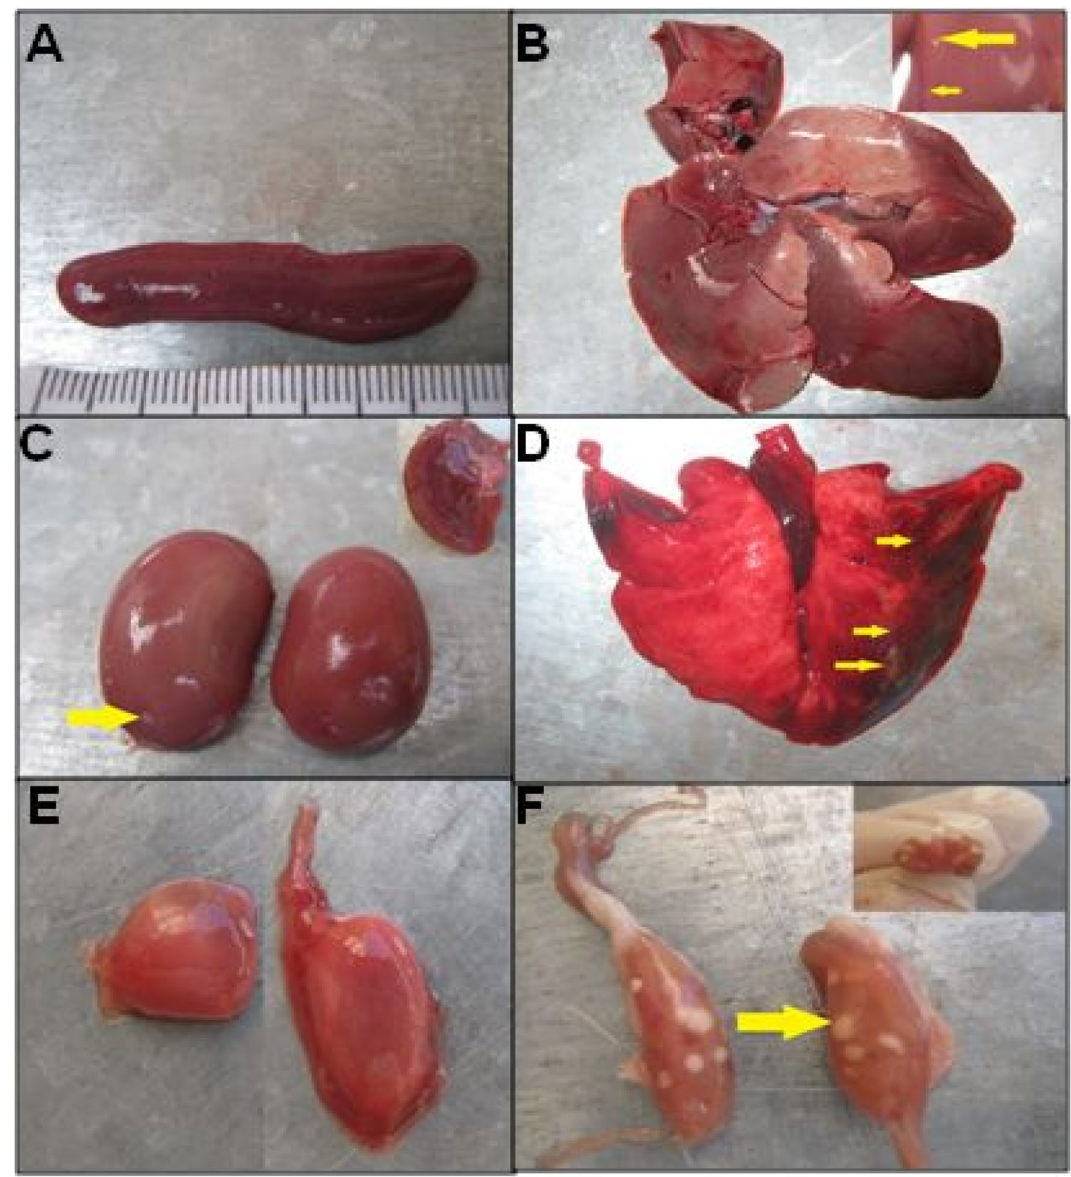
Figure 3. Organ lesions in wild rabbit (Hunted animal). ( A ): Splenomegaly. The spleen is markedly enlarged (5 cm in length) and has prominent rounded edges. ( B ): Heterogeneous discoloration in the liver lobes with hemorrhage areas and a few small white necrotic foci (arrow). ( C ): Congestion of the kidney with a white focus of necrosis foci in the capsule (arrow). ( D ): Pneumonia with multifocal hemorrhages and dark hyperemic areas are scattered throughout the lungs, also few small white necrotic foci (arrow). ( E ): The enlargement of adrenal glands. ( F ): Numerous necrotic white foci in the